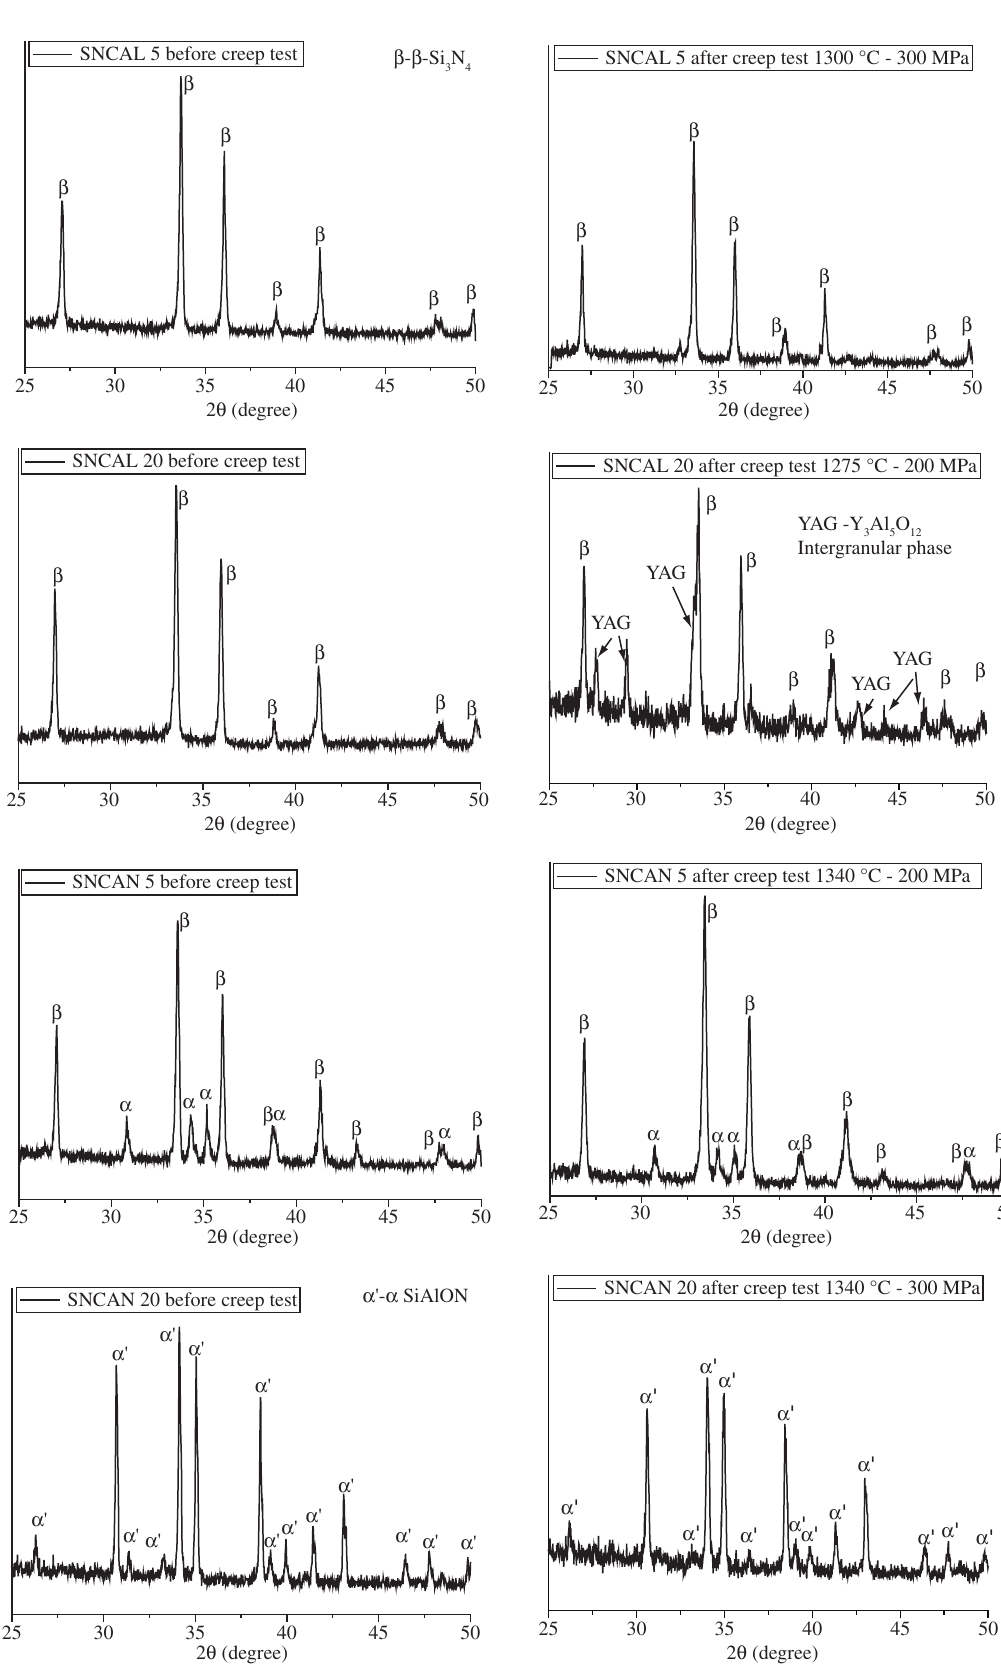
Figure 3. X ray diffraction patterns of the composition